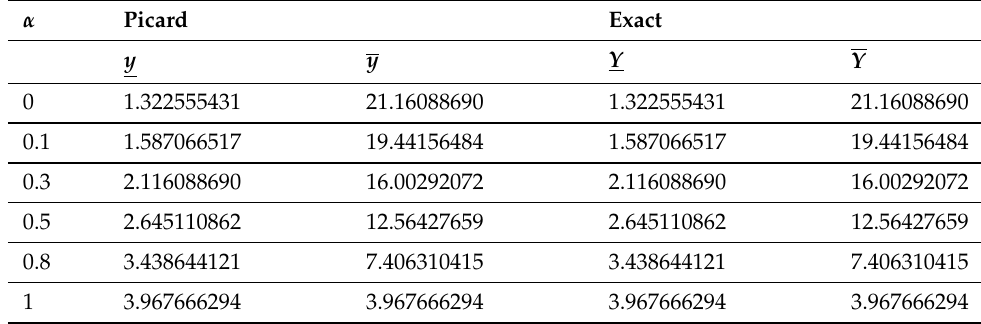
Table 8. Exact and numerical values (Picard’s method) for the 1-solution at t = 1.5.